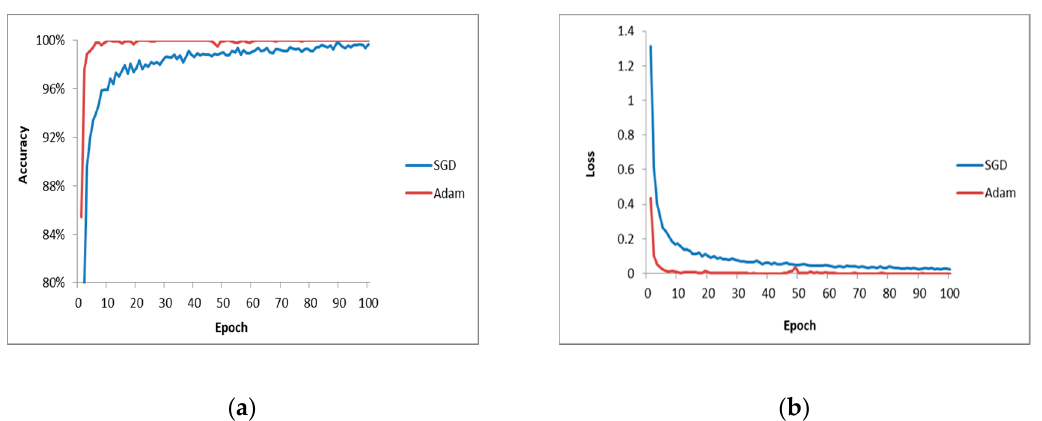
Figure 8. Comparison of the optimal algorithms: ( a ) accuracy values; ( b ) loss values.